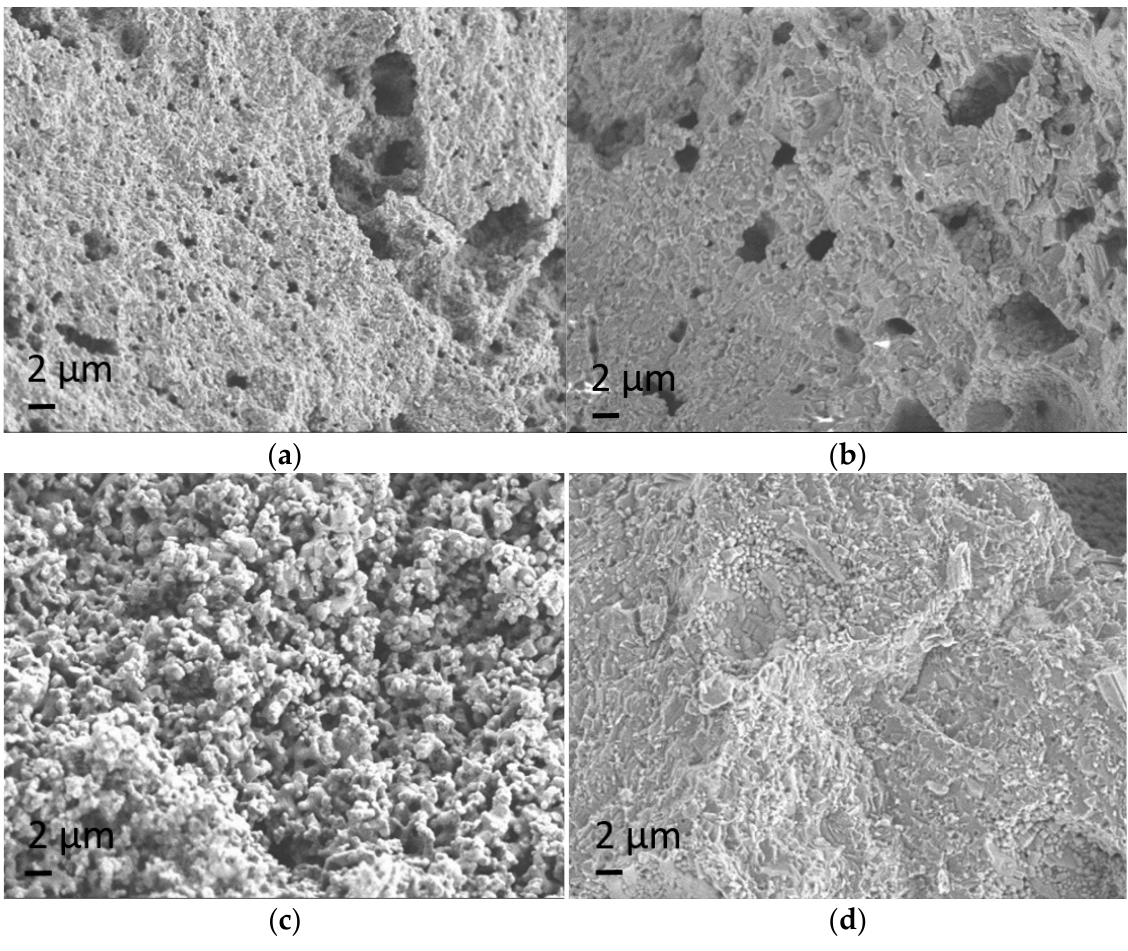
Figure 6. Micrographs of the ceramic samples prepared based on the synthesized CPP/CC powder at a pressure value of 100 MPa: ( a )—chip of a tablet fired at 700 °C without the introduction of an additive; ( b )—chip of a tablet fired at 800 °C without the introduction of an additive; ( c )—chip of a tablet fired at 700 °C with the introduction of an additive; ( d )—chip of a tablet fired at 800 °C with the introduction of an additive.